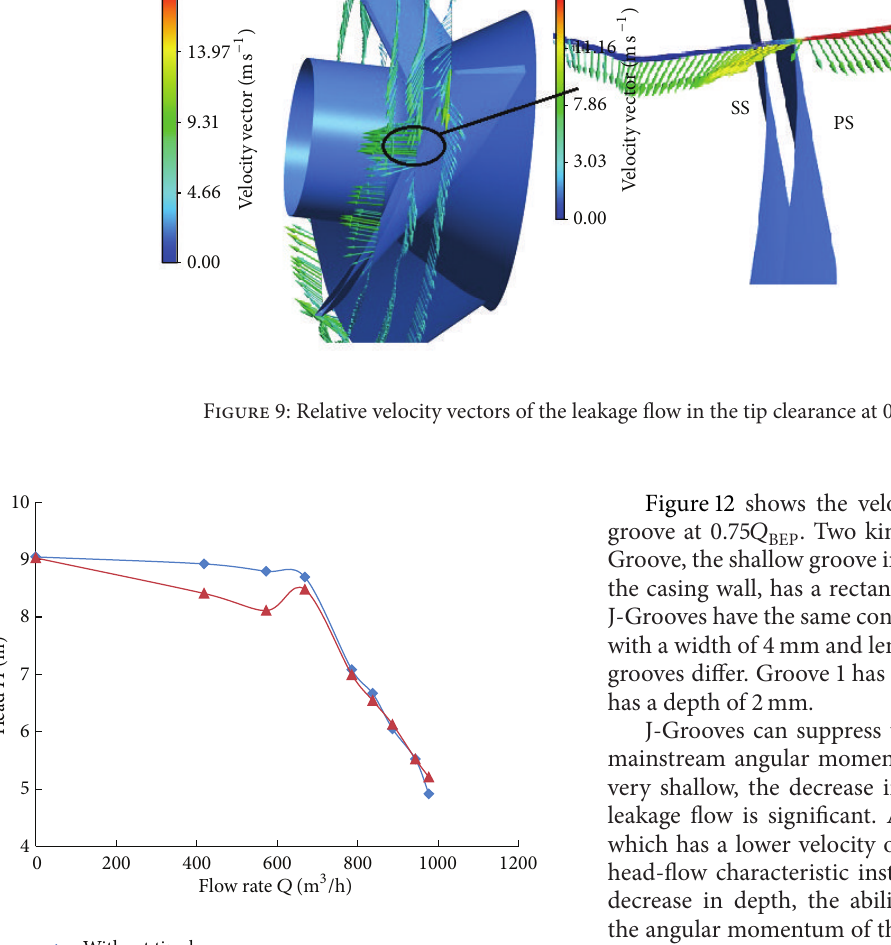
Figure 10: Head curves of the pump with and without tip